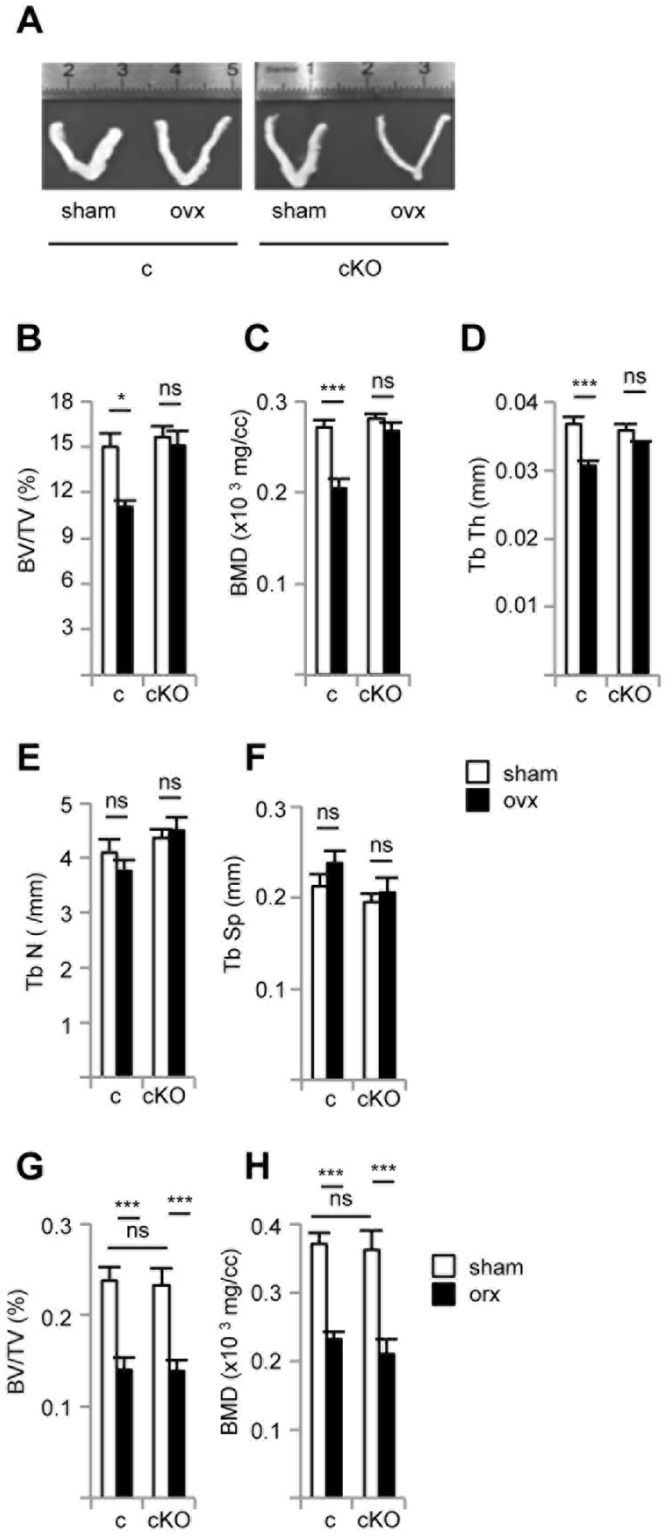
Conditional inactivation of ERRα in vivo protects against ovariectomy-induced bone loss.
A. Photograph of uteri in sham-operated or ovariectomized (ovx) control (c) or cKO mice. B–F. Same parameters as in Fig. 3 were determined in females either sham-operated (white bars) or two weeks after ovariectomy (ovx; black bars). BV/TV (G) and BMD (H) were determined in male mice either sham-operated (white bars) or four weeks after orchidectomy (orx; black bars). All mice (n = 6 to 10 per group) were 14 wk old at the end of the experiment. Error bars represent s.e.m. *: p<0.05; ***: p<0.005; ns: non significant.